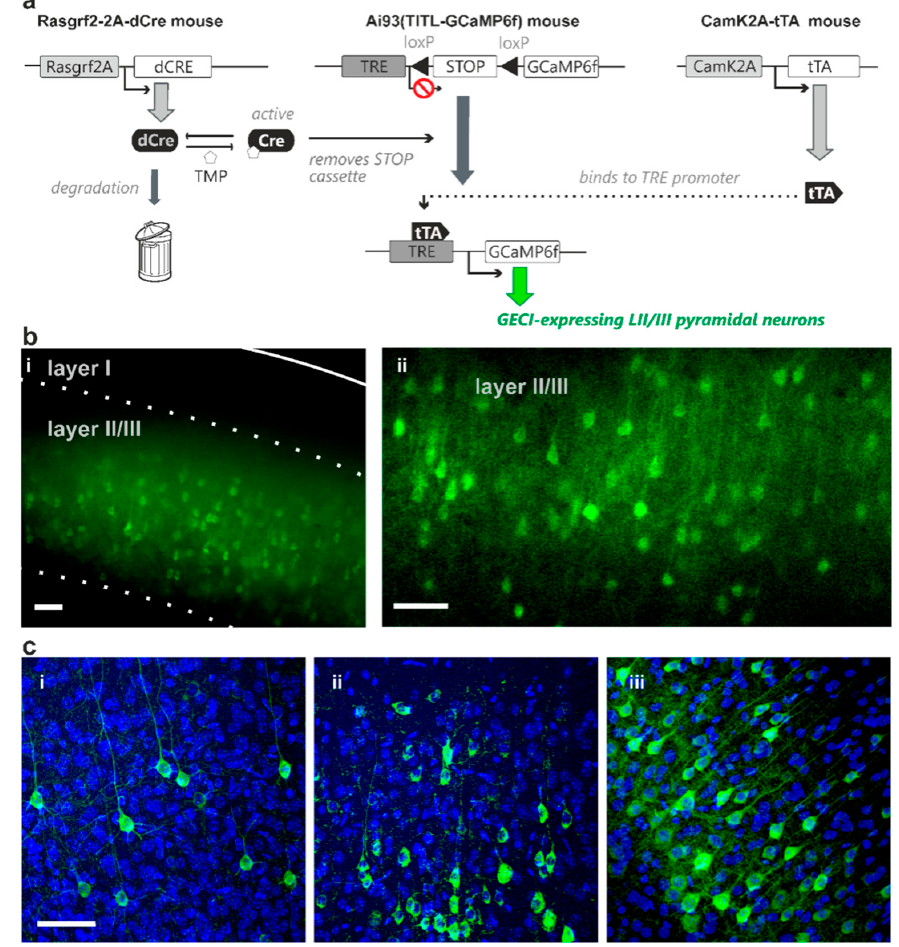
Figure 1. Representative images of adjusted GECI expression probability of layer II/III pyramidal neurons achieved via dose-dependent TMP administration. ( a ) Transgenic strategy using the combination of both Cre-recombinase and transactivator intersectionally controls indicator expression in identified cell populations in Ai93 GCaMP6f indicator transgenic mice. The transgenic